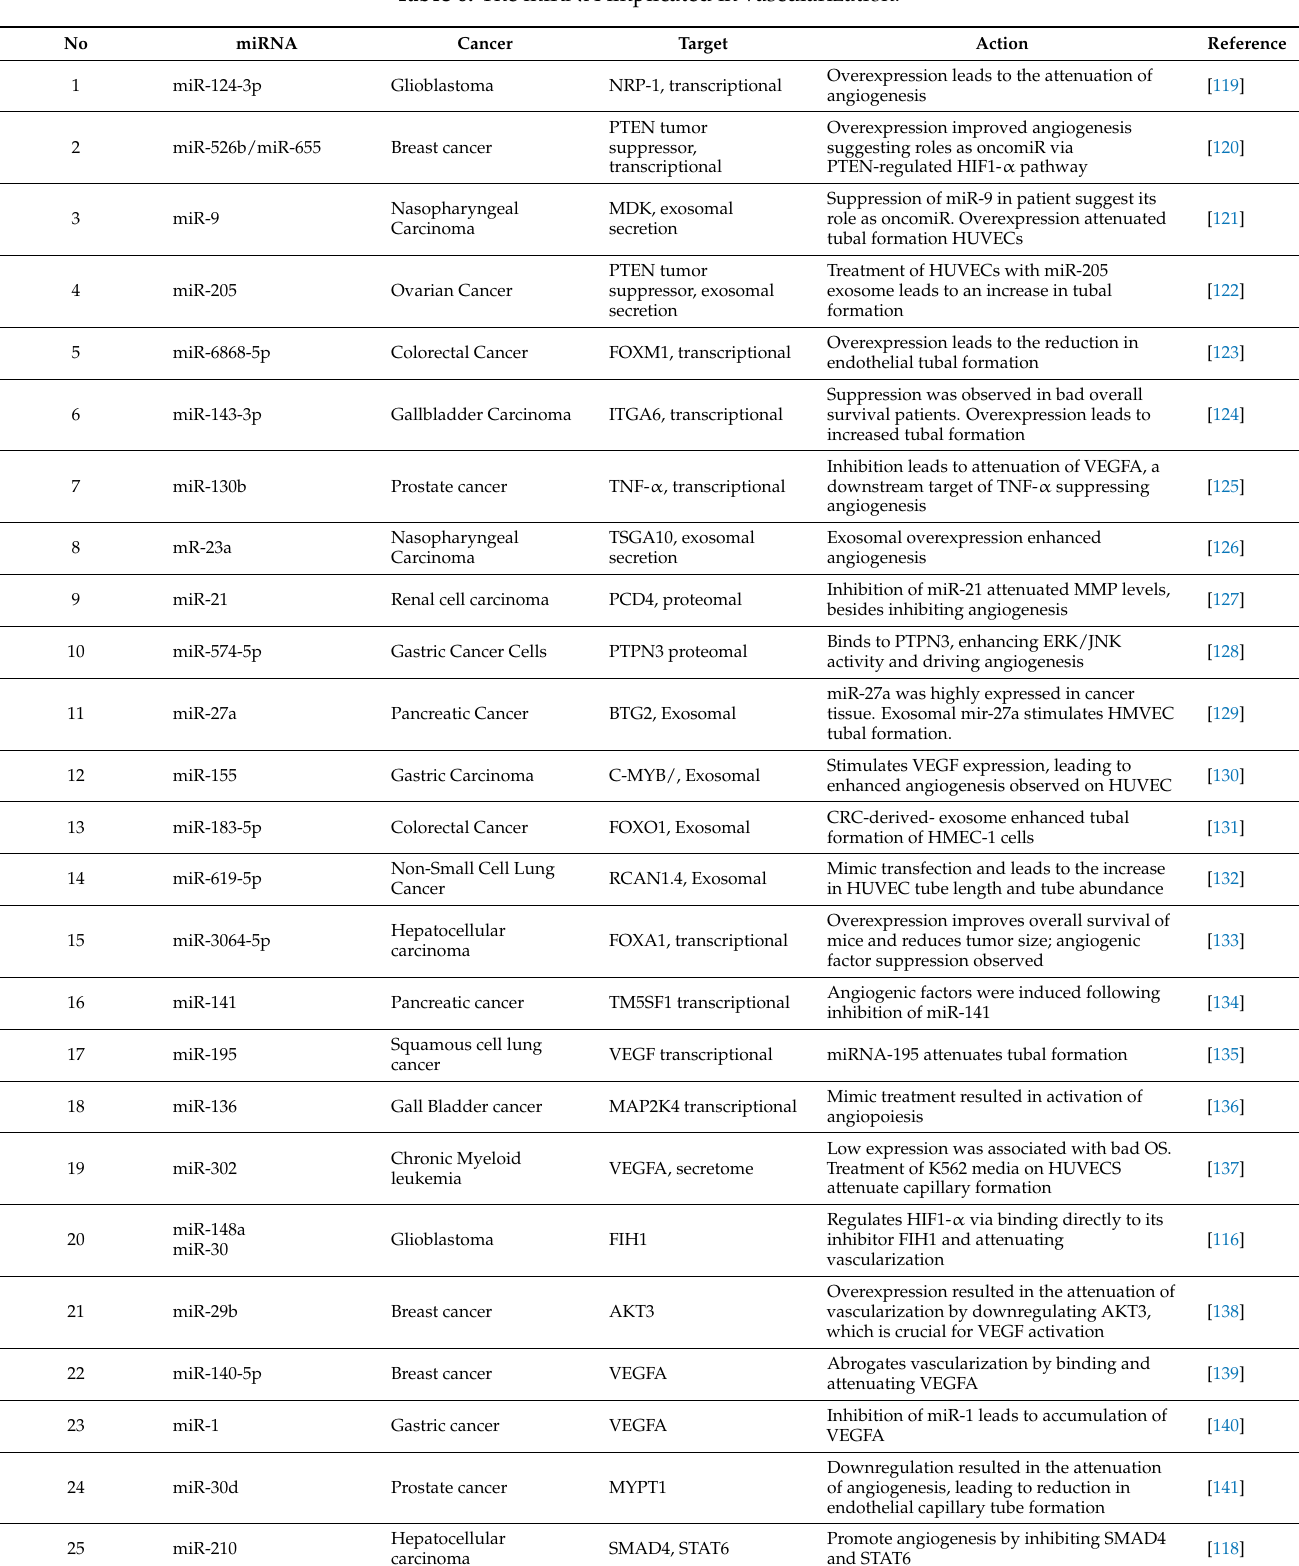
Table 6. The miRNA implicated in